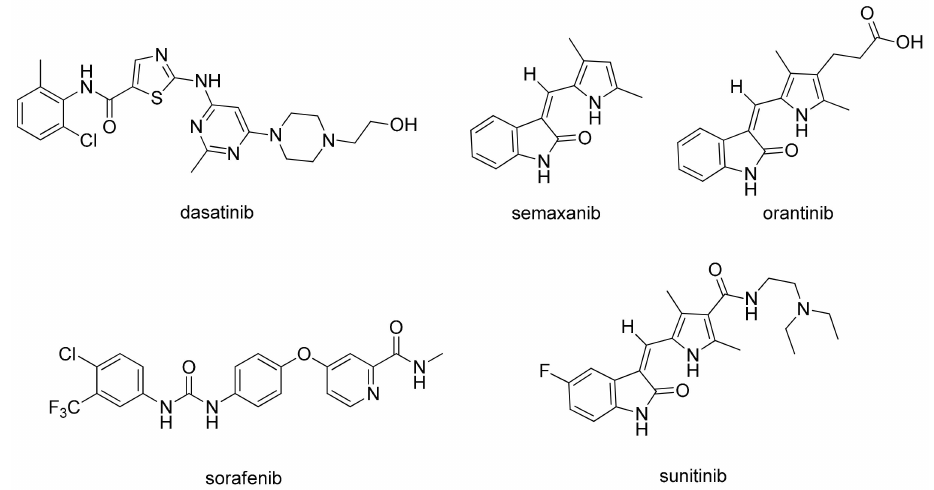
Figure 1. The structures of some multi-targeted kinase inhibitors. Some inhibitors, such as